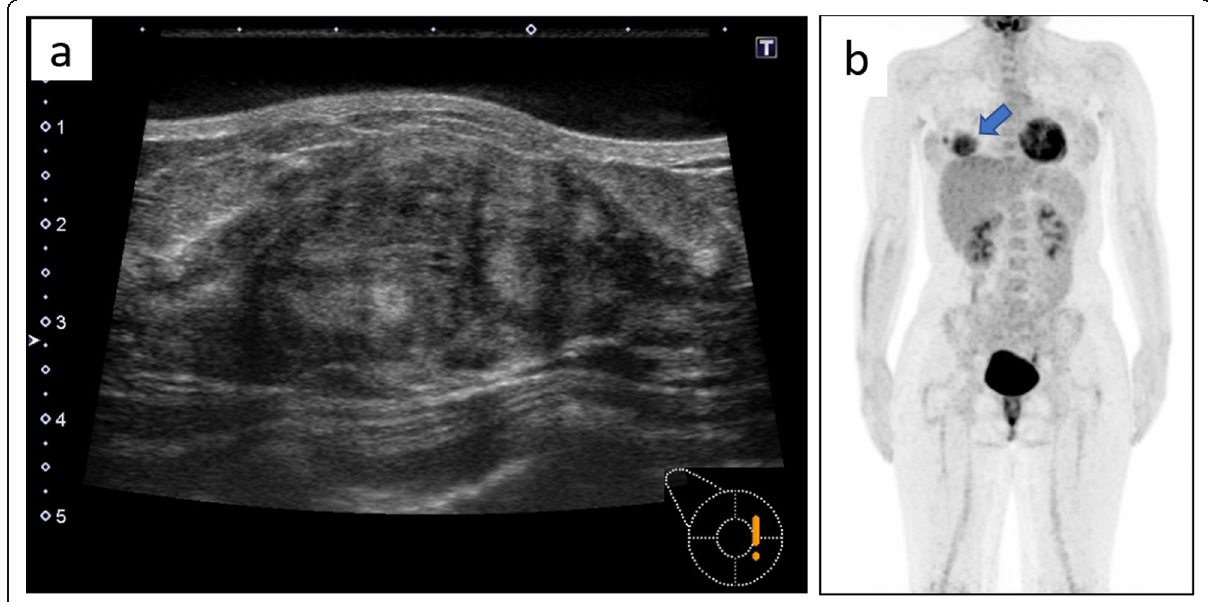
Fig. 1 Findings of ultrasound and PET-CT scan. a Ultrasonography revealed a 40-mm tumor with an irregular shape. Internal echo was a mixture of low and high levels, suggesting that fibroadenoma, breast cancer, and sarcoma should be included in the differential diagnosis, along with lymphoma. b PET-CT scan showed high FDG uptake in the right breast (blue arrow). There were no abnormal hot spots in other organs, including the ipsilateral